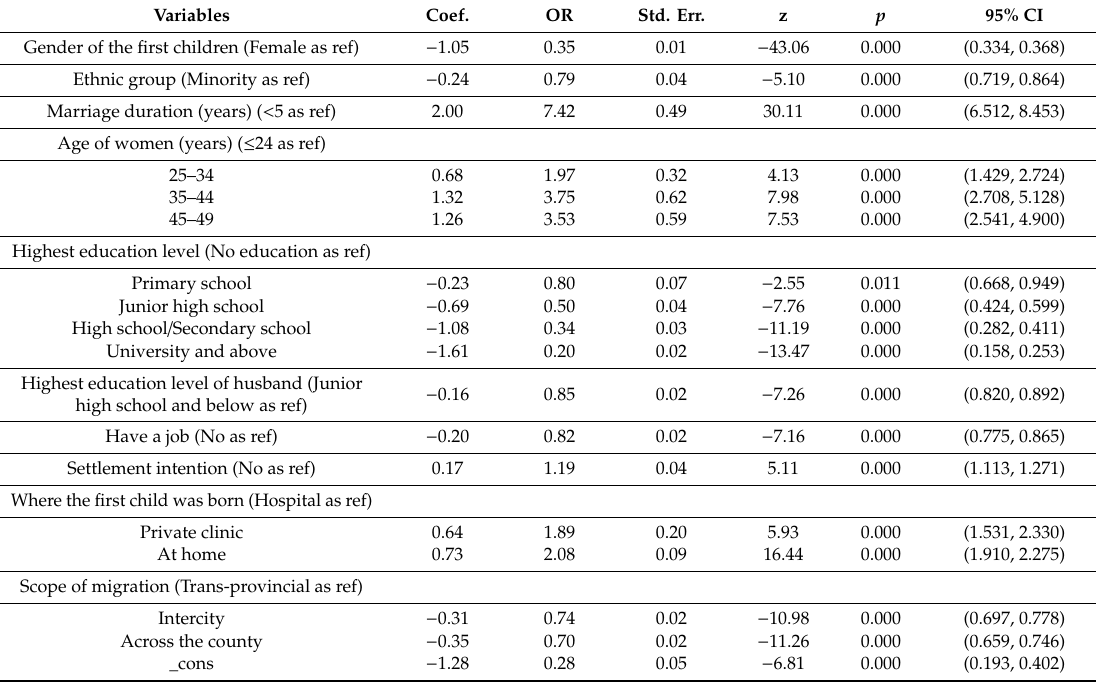
Table 6. Binary logistic regression analysis of factors influencing reproductive behavior.